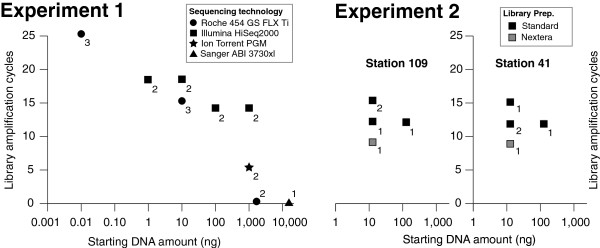
Experimental design overview. Library preparation treatments were done at varying levels of replication, as indicated by the numbers (1 to 3) next to each treatment. The number of amplification cycles (see y axis) includes those necessary to generate enough DNA for library preparation, but does not include the emPCR (454, Ion Torrent) or bridge (Illumina) amplification cycles used to build large enough populations of reads for nucleotide sequencing signal detection.